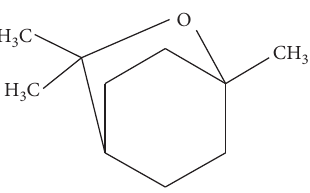
Figure 1: The chemical structure of 1,